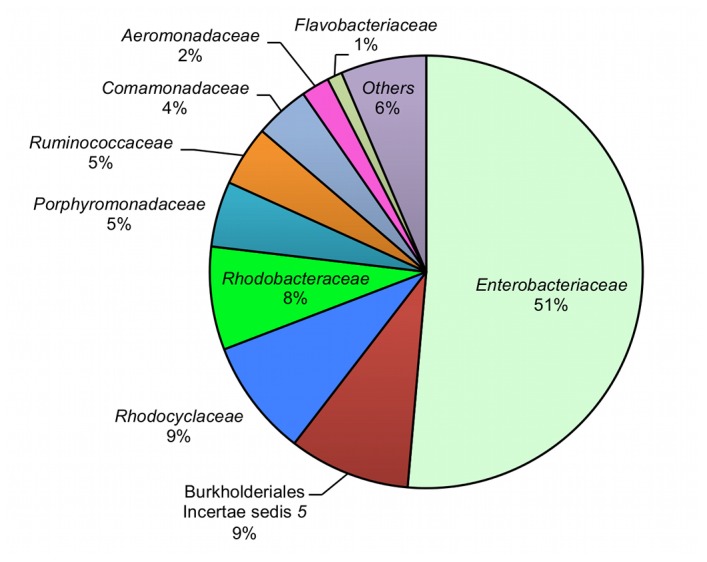
Family-level classification of bacterial communities in mosquitoes.Family-level classification of bacterial communities in C. tarsalislarvae and their relative proportions.